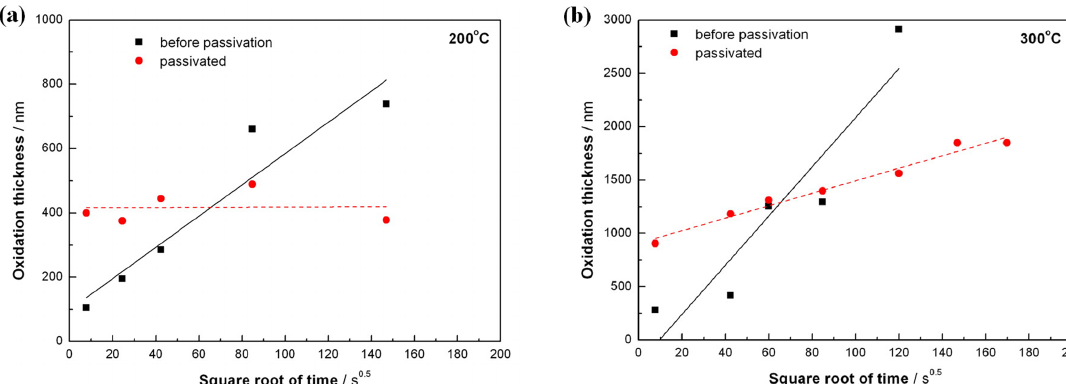
Figure 7. Oxidation kinetics of Cu plates oxidized at (a) 200 °C and (b) 300